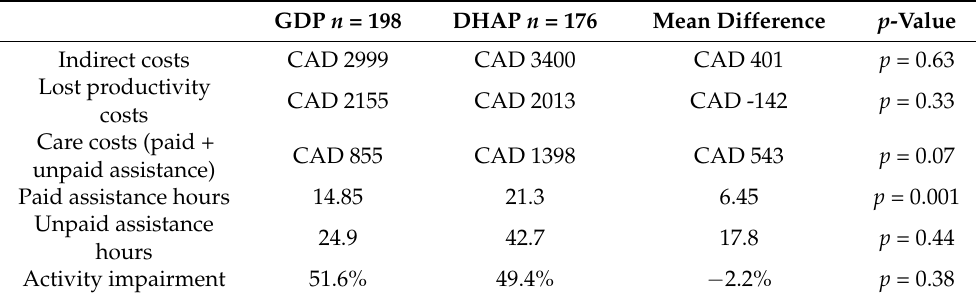
Table 2. Indirect costs associated with the two treatment